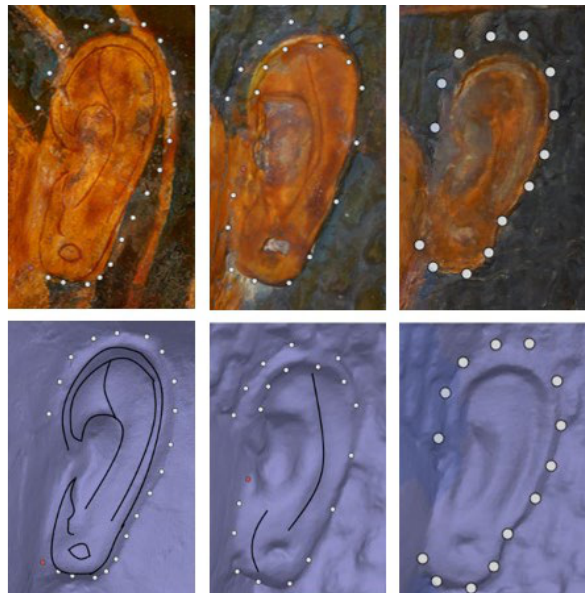
Figure 5. Detail of the left ears of Butehamon’s coffin set with and without texture. White dots higlight the geometry that, in the upper part of the ear, does not correspond to the painting.